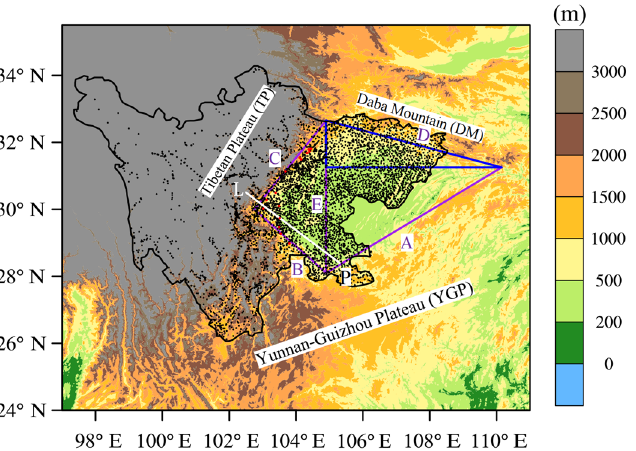
Figure 1. Distribution of topography (shaped) and stations (black dots) in Sichuan Province (red dots represent rainstorm center stations in 15 cases). Solid black lines represent the boundaries of Sichuan Province. SCB (Sichuan Basin) is surrounded by boundaries A, B, C, and D. Western SCB (mountainous areas around the western Sichuan Basin) is surrounded by boundaries B, C, and E. The blue triangle represents northeastern SCB (mountainous areas around the northeastern Sichuan Basin). The white line L intersects boundary A at point